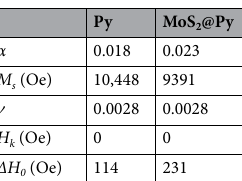
Table 1. The α , M s , γ , H k , ΔH 0 obtained from the fitting of FMR